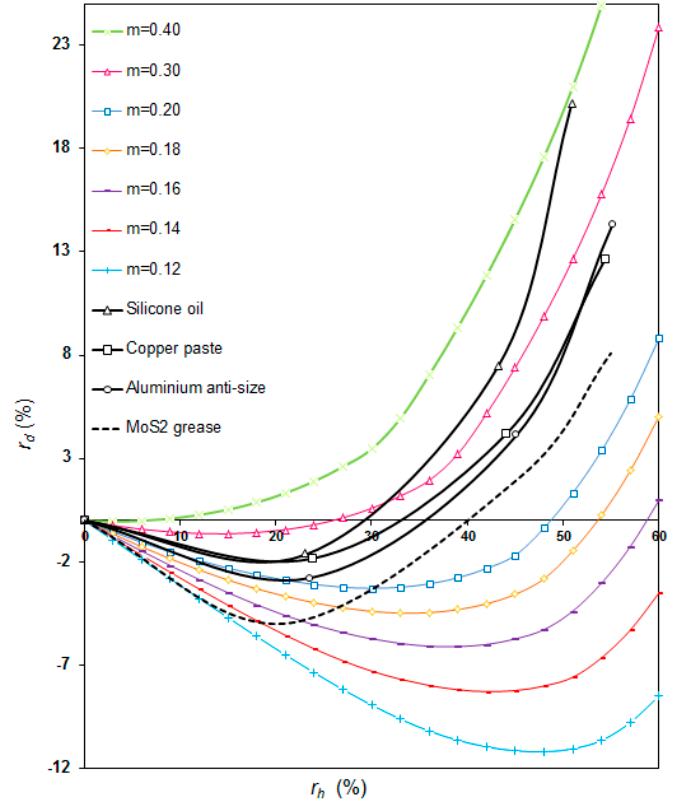
Figure 12. Dual friction factor map for UNS A96082 experimental results.